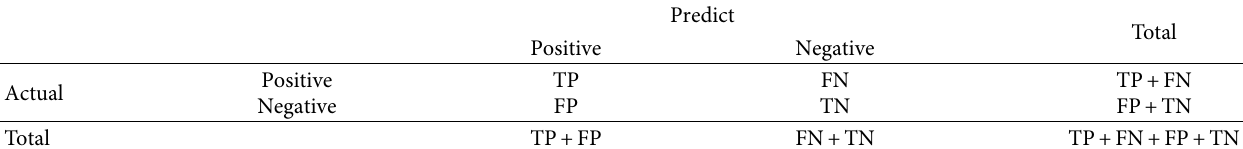
Table 2: Confusion matrix.